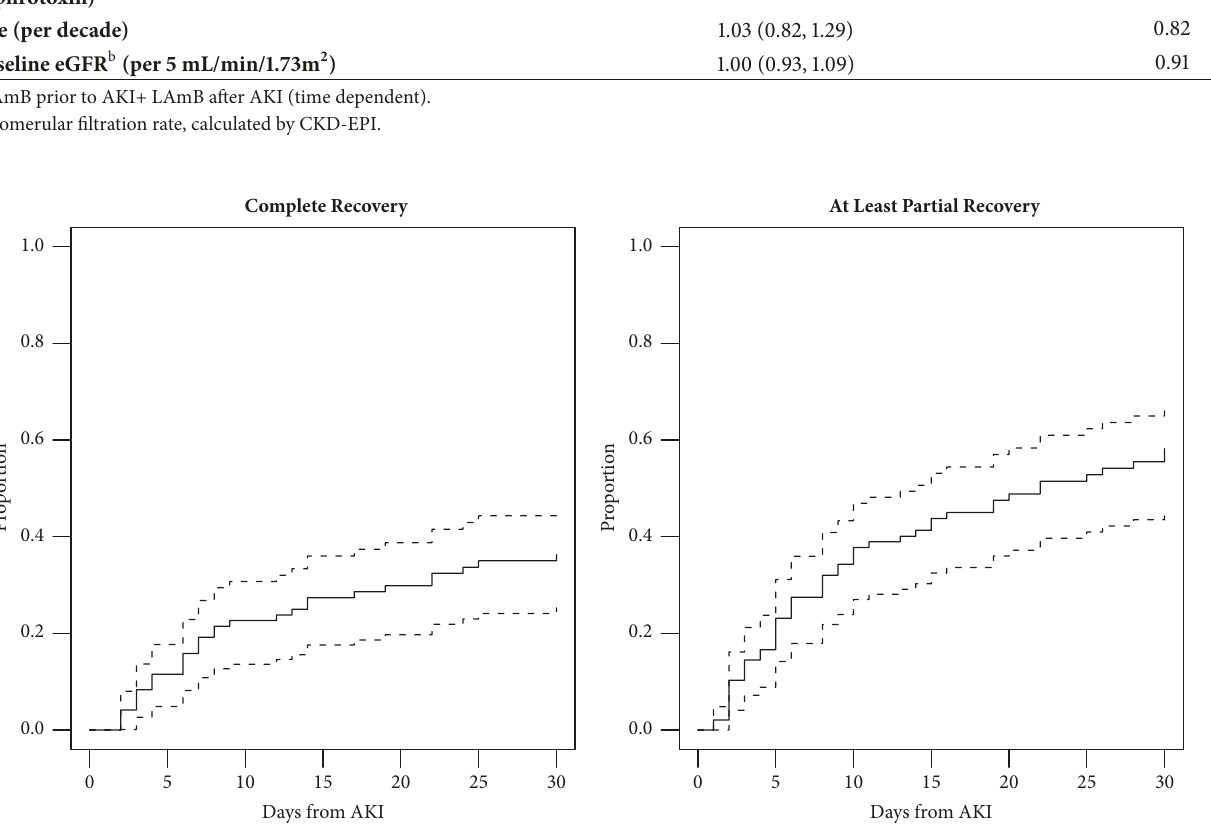
Figure 2: Kaplan Meier curves depicting complete recovery and at least partial recovery over the course of 30 days from AKI. The dotted lines represent 95% confidence